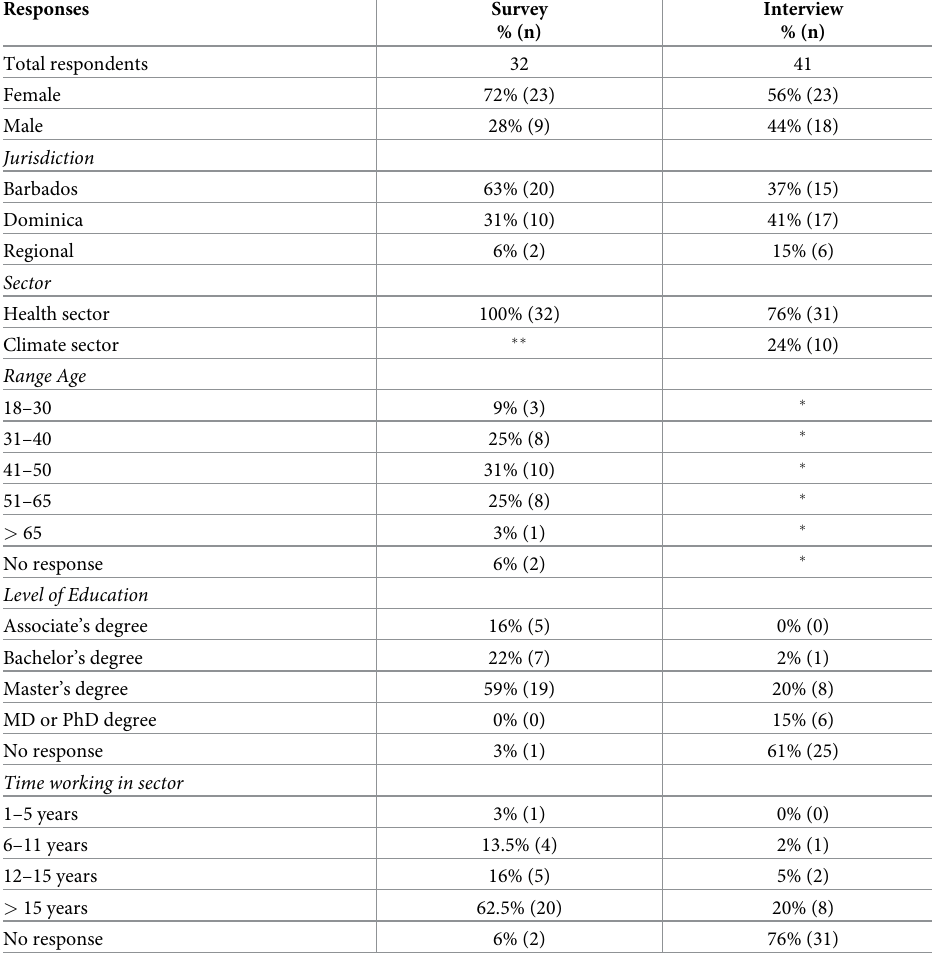
Table 2. Demographics of survey and interview